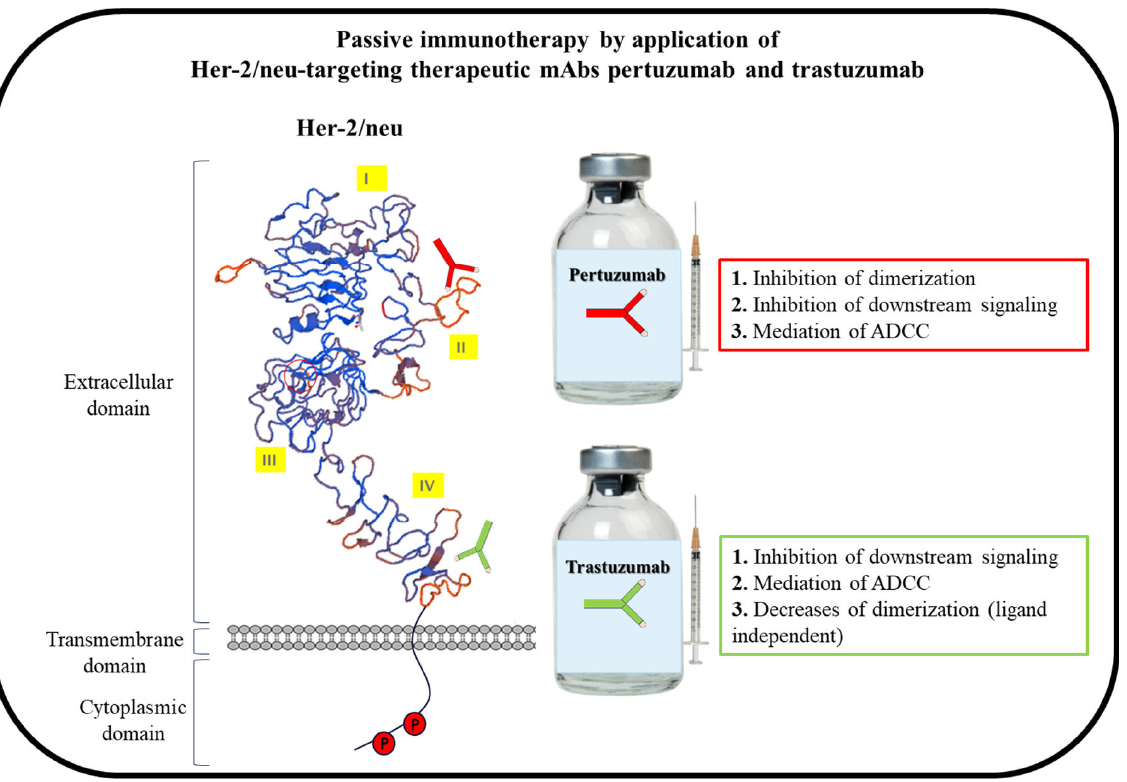
Figure 1. Schematic description of passive immunotherapy with Her-2/neu-targeting therapeutic mAbs pertuzumab and trastuzumab. The mAbs bind to their respective B cell epitopes on extracellular domain II (pertuzumab) and IV (Trastuzumab) of Her-2/neu. The mAbs’ modes of action upon their binding to the receptor are shown in the respective boxes. Adapted with permission from Ref. [62]. Elsevier, 2022.